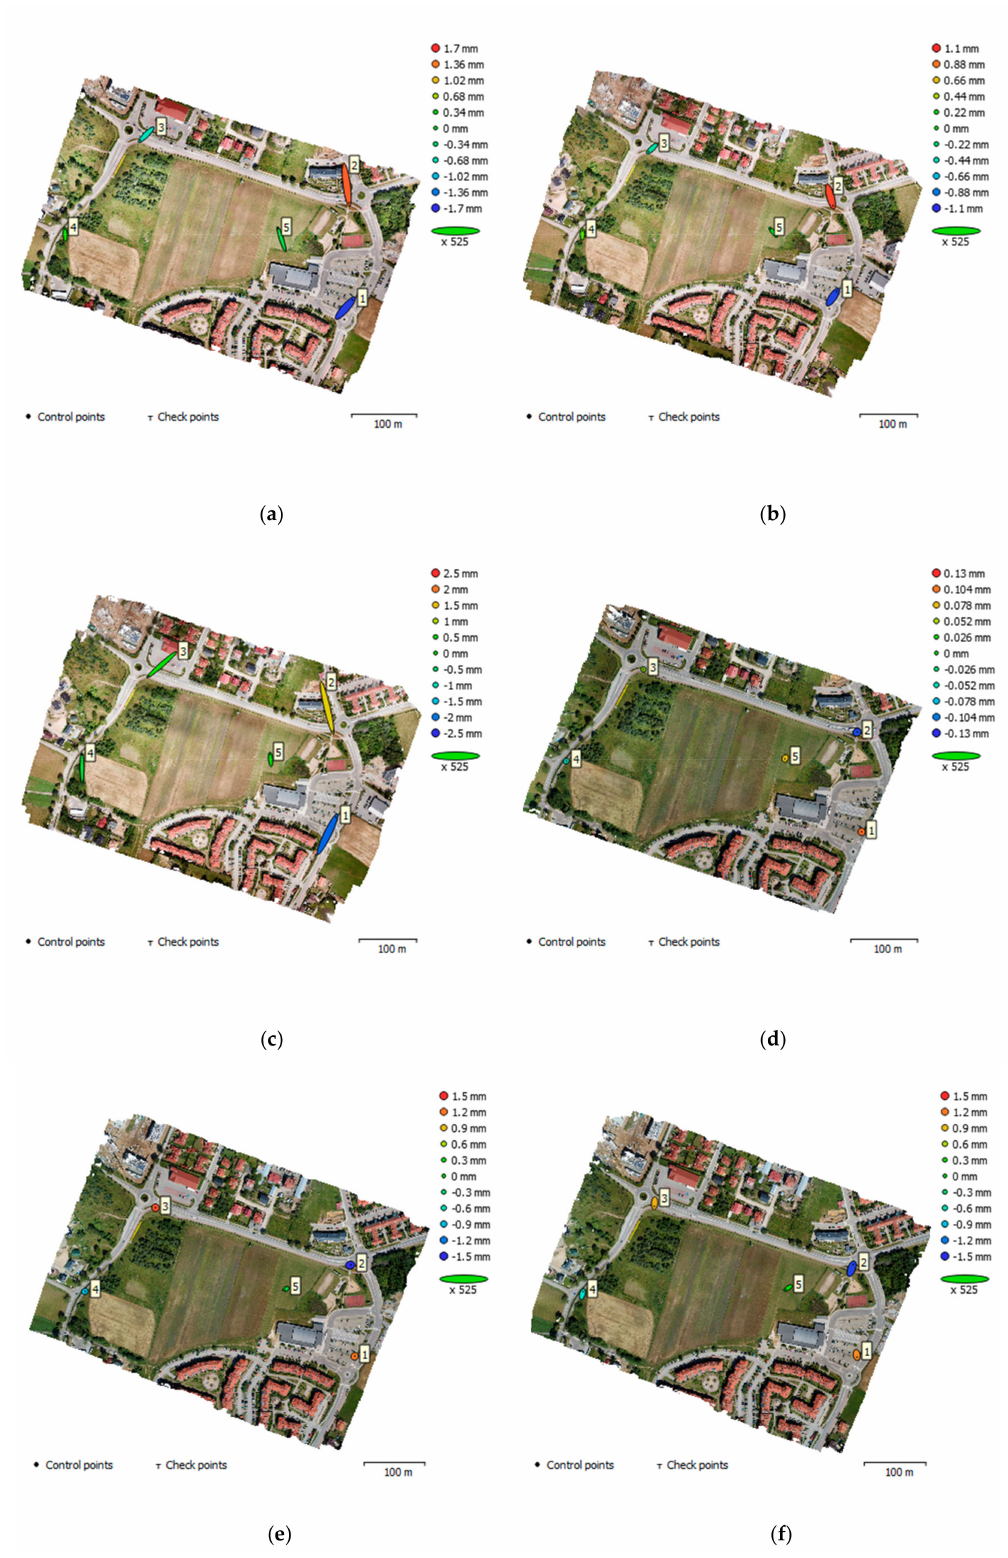
Figure 5. GCP locations and error estimates for the Mavic Pro: ( a ) at 55 m, ( b ) at 110 m, and ( c ) SR and for the Phantom 4 Pro: ( d ) at 55 m, ( e ) at 110 m, and ( f ) SR. Z error is represented by the ellipse color. X,Y errors are represented by the ellipse